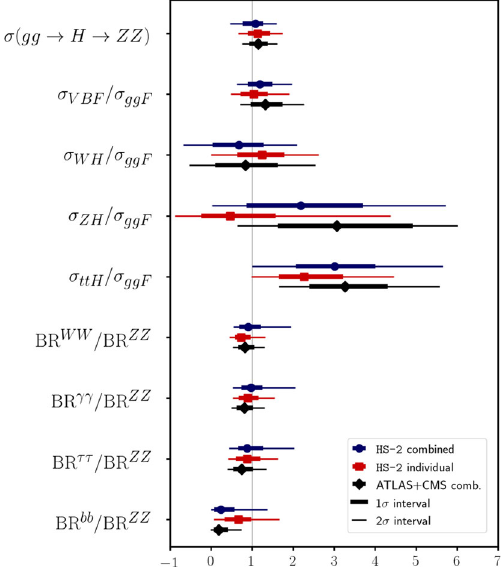
Fig. 8 Results obtained with HiggsSignals-2 in comparison with the official fit results for the σ( gg → H → Z Z ) cross sec- tion and for ratios of cross sections and branching fractions. The HiggsSignals-2 results using the combined ATLAS and CMS data and the results using the individual signal strength measurements as experimental input are shown in blue and red, respectively. Also shown are the official results from ATLAS and CMS (black). The error bars indicate the 1 σ (thick lines) and 2 σ (thin lines) intervals. The results are normalised to the respective SM